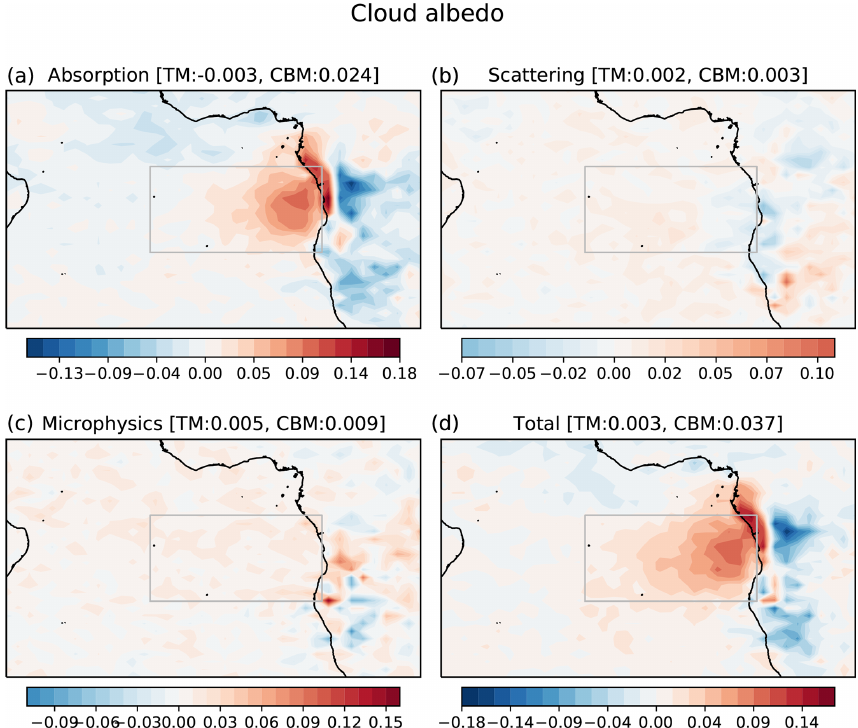
Figure 8. UKESM1 International Satellite Cloud Climatology Project (ISCCP) simulator mean spatial distribution of the BBA effects of (a) absorption, (b) scattering, (c) microphysical, and (d) total on the cloud albedo during July and August 2016–2017. The domain range is from 30 ◦ S to 10 ◦ N and from 40 ◦ W to 30 ◦ E. The TM is the total mean of the domain and the CBM is the mean of the cloud box (the grey box on the map) representing the areas where the average low cloud fraction is above 0.58. The same colour scale is used in each plot to facilitate comparison, but the colour map ranges differ in each plot, corresponding to the maximum and minimum variation of cloud albedo in